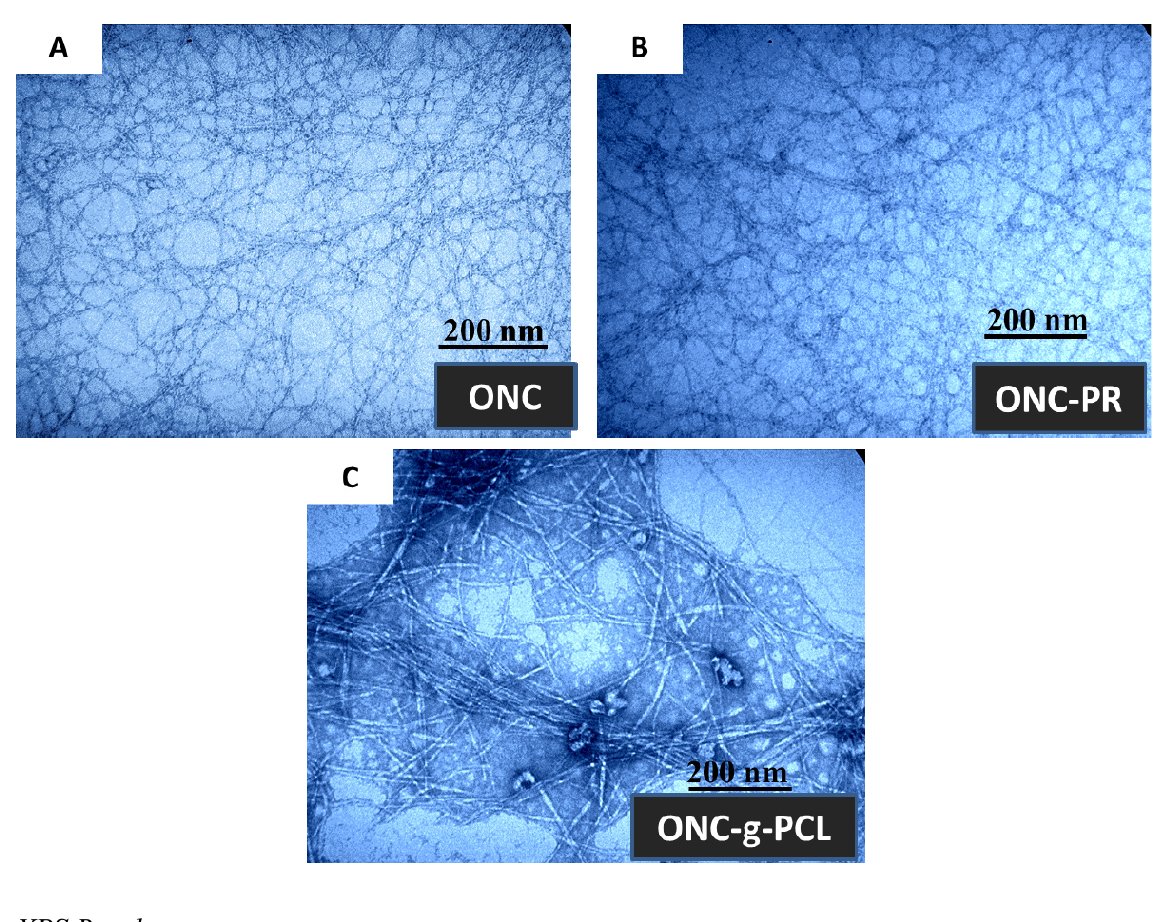
Figure 4. Transmission electron micrographs of: ( A ) ONC, ( B ) ONC-PR and ( C )